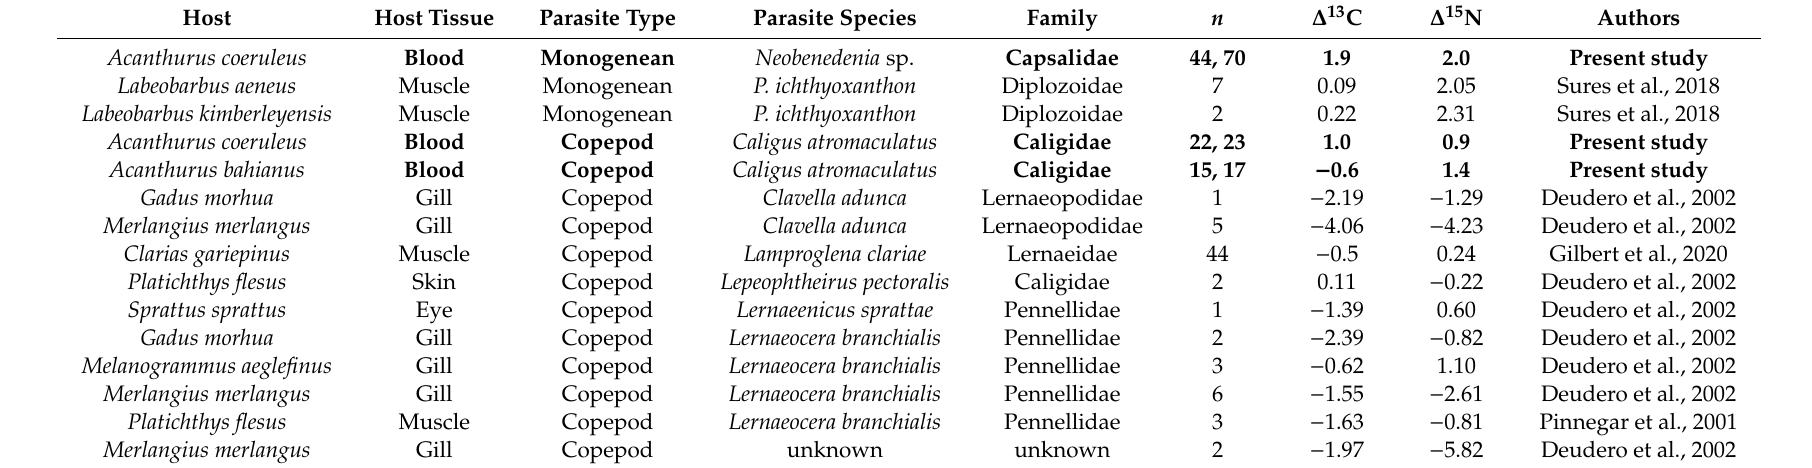
Table 4. Summary of data on parasite-host discrimination factors (% (cid:24) ) and sample sizes ( n ) for monogeneans and parasitic copepods. Data from this study are in bold. Samples sizes for present study are reported for both ∆ 13 C and ∆ 15